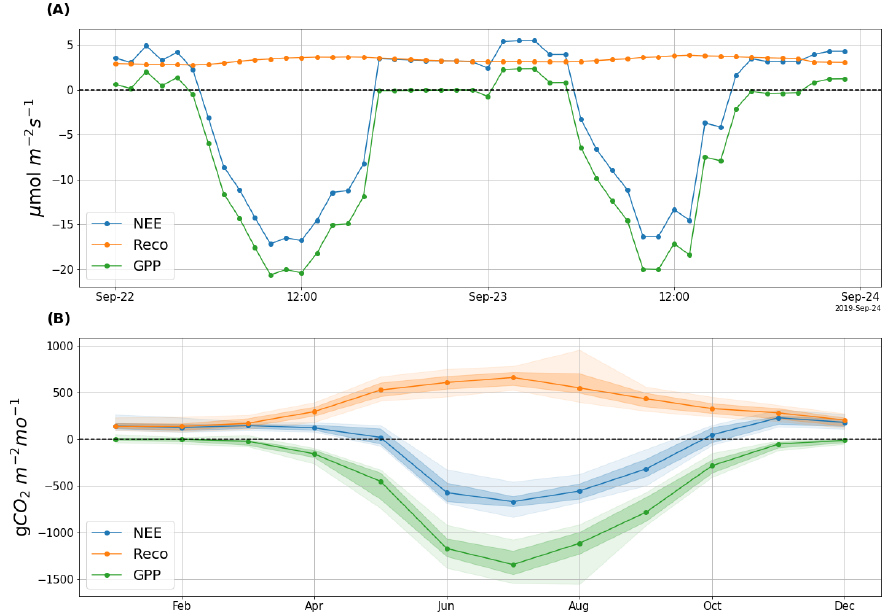
Figure A1. From hourly to yearly NEE (blue), R eco (orange), and GPP (green) scales. ( A ) Example of hourly fluxes from 22 September 2019 and 23 September 2019. ( B ) Median values of the three variables (lines), values between the first and third quartiles (heavily shaded areas), and values between the 10 and 90 percentiles (lightly shaded areas) for monthly sums. In December, January, February, and March, monthly GPP is close to zero and NEE is mostly R eco , producing a net emission (Figure A1B), which is coincident with the dormant period of the vegetation when all the leaves from the trees fall and the plants diminish its photosynthesis rate. However, around summer (from May to October ap- proximately), the growing season starts, the forest canopy turns full of green leaves and increases their GPP. This produces net sequestration that compensates the emissions from the other months, resulting in negative NEE values on every year (Figure 1B from the main text). More details about the differences in NEE, R eco , and GPP distributions during the growing (weeks 21–40; higher mean and variance) and dormant (weeks 41–19; mean and variance closer to zero) seasons and how they aggregate to produce yearly histograms are illustrated in Figure A2.